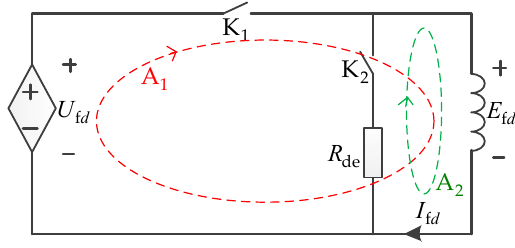
Figure 1. Physical model of the SC’s excitation Figure 1 . Physical model of the SC’s excitation winding.